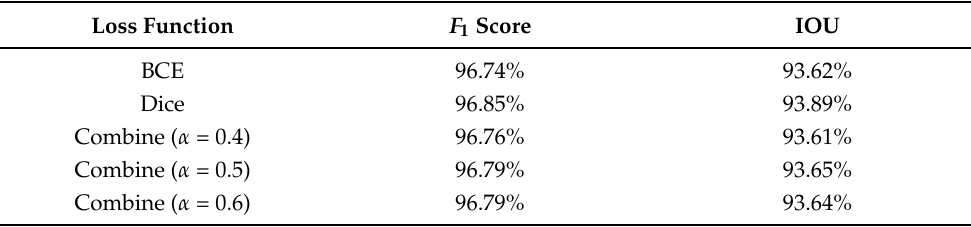
Table 4. The performance comparison of the proposed STEB-UNet with different loss function on the WHU dataset.